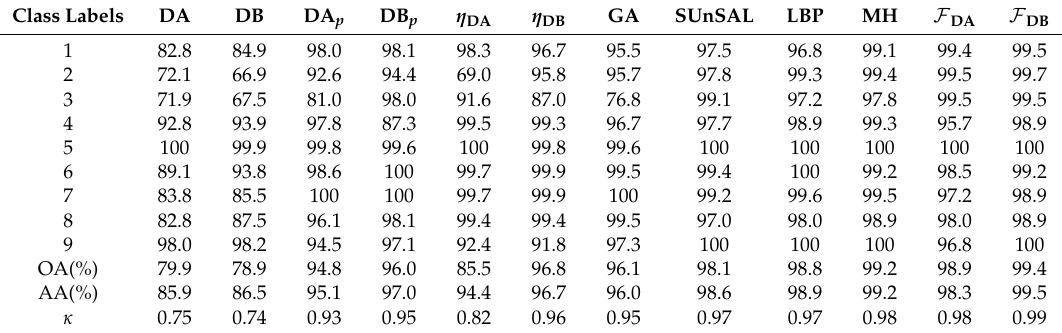
Table 3. University of Pavia dataset: OA, AA and κ value of the classification results. The best classification accuracies are marked in bold.